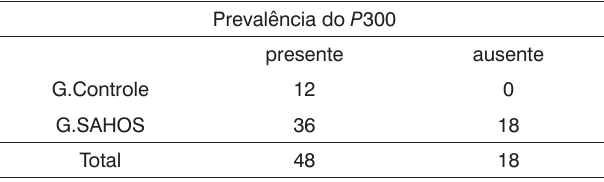
Tabela 1. Prevalência do P 300 nos G.C. e G.SAHOS. Prevalência do P 300